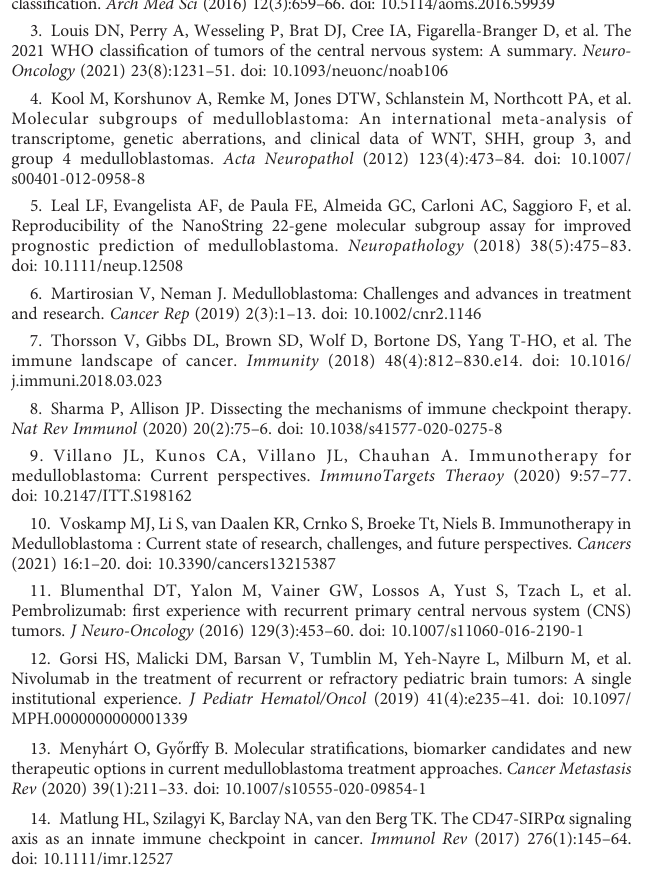
SUPPLEMENTARY FIGURE 1 Graphic representation of HAVCR2, LAG3, and TIGIT mRNA normalized expression levels of the 80 medulloblastomas analyzed by nCounter. (A) The plot of mRNA levels of all medulloblastomas for HAVCR2, LAG3, and TIGIT (B) Plot of HAVCR2, LAG3, and TIGIT mRNA levels by molecular subgroups. The continuous line in each graph marks the background threshold of 20 mRNA normalized expression counts. The plots were obtained through GraphPad Prism